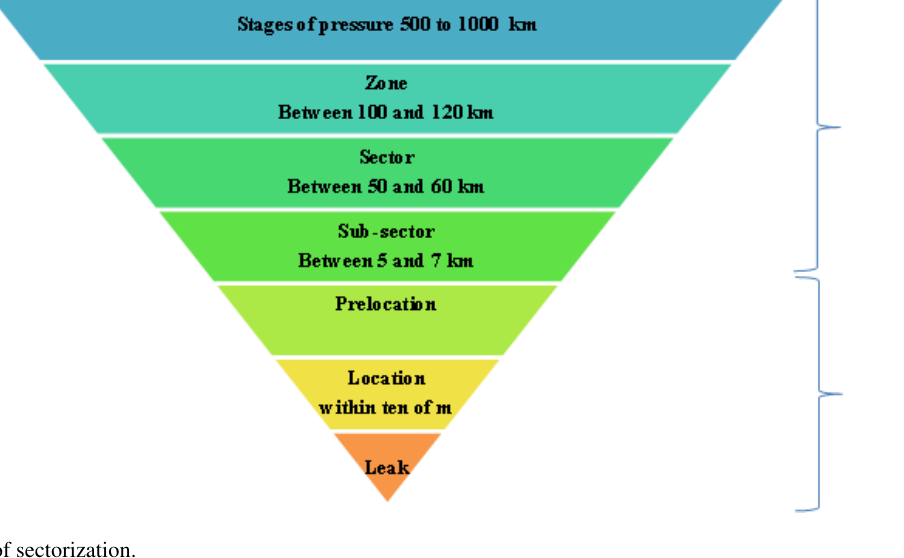
Figure 9. Stages of